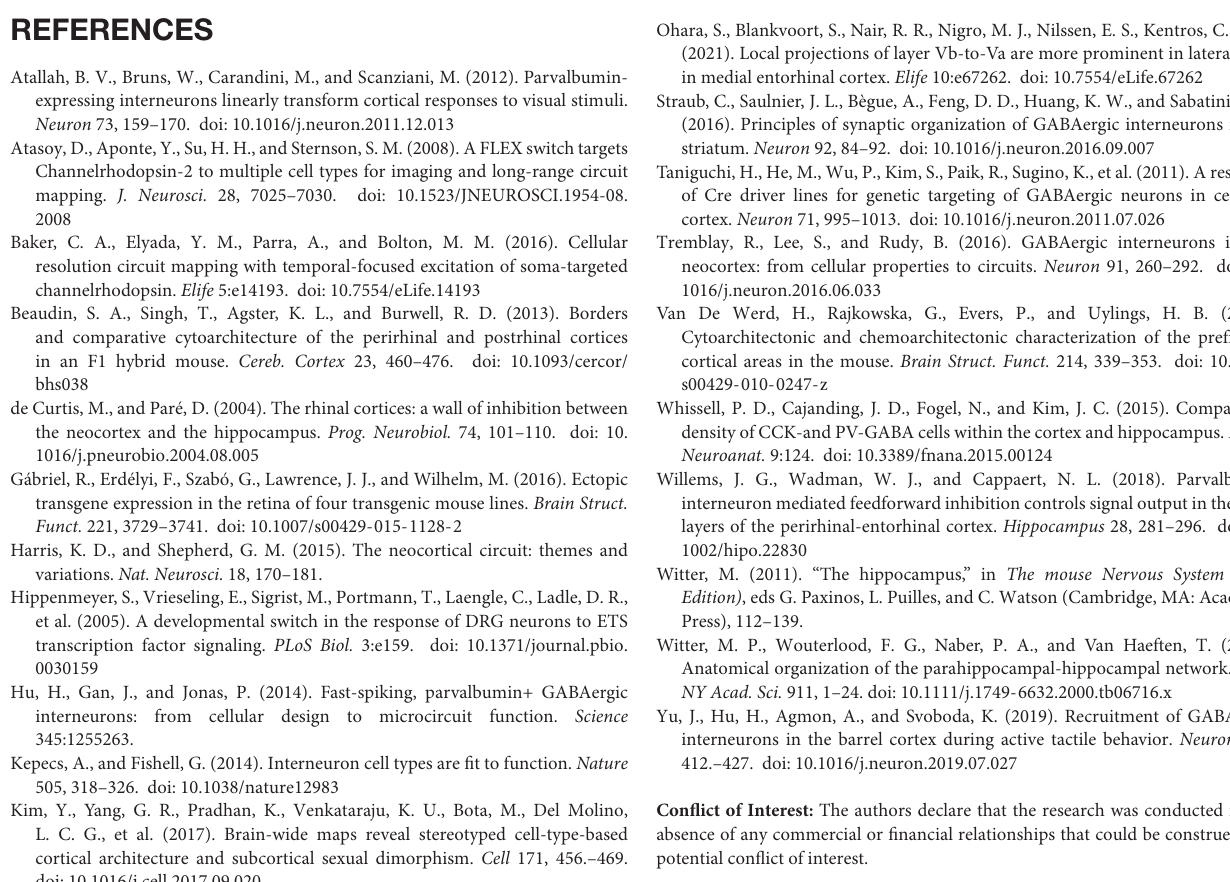
Supplementary Figure 1 | (A–C) Representative immunostainings showing the expression of tdTomato ( A , red), PV ( B , green) and the merged image (C) in the perirhinal cortex of the PV-IRES-Cre line using a primary mouse anti-PV antibody. (D) Bar plot showing the densities of PV immunoreactive (PV-IR) neurons (green) and tdTomato expressing neurons (red). (E) Bar plot showing the specificity obtained with the mouse anti-PV. (F) Efficiency obtained with the mouse anti-PV. © 2011 Allen Institute for Brain Science. Allen Mouse Brain Connectivity Atlas. Available from: https://connectivity.brain-map.org/. Supplementary Figure 2 | Comparison of the PV-IRES-Cre and PV-T2A-Cre mouse lines in the PER. (A) PER of a PV-IRES-Cre mouse showing ISH for Cre. (B) PER of a PV-T2A-Cre mouse showing ISH for Cre. (C) PER of a PV-IRES-Cre mouse showing ISH for td-Tomato. (D) PER of a PV-T2A-Cre mouse showing ISH for tdTomato. (E–J) FISH for PV and td-Tomato in PV-IRES-Cre ( E , merged; G , PV; I , td-Tomato), and in PV-T2A-Cre ( F , merged; H, PV; J , td-Tomato). Green arrows point to PV-expressing neurons that do not express tdTomato. Red arrows point to td-Tomato neurons that do not express PV. LEC, lateral entorhinal